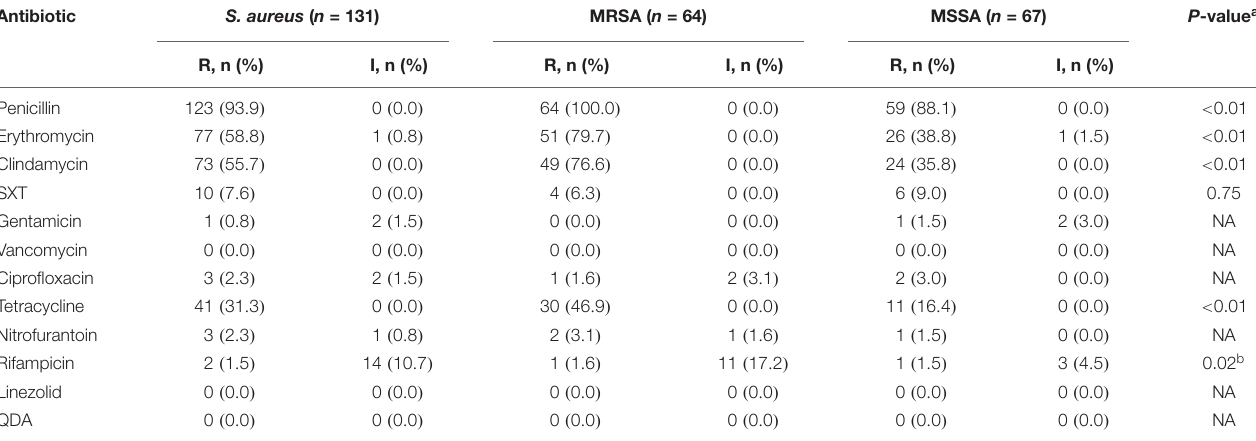
TABLE 1 | Antibiotic profiles of Staphylococcus aureus isolated from women and children in Guangzhou, China. Antibiotic